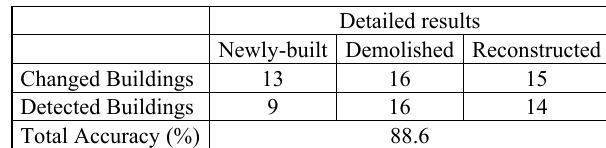
Table 1. Detailed results of building change